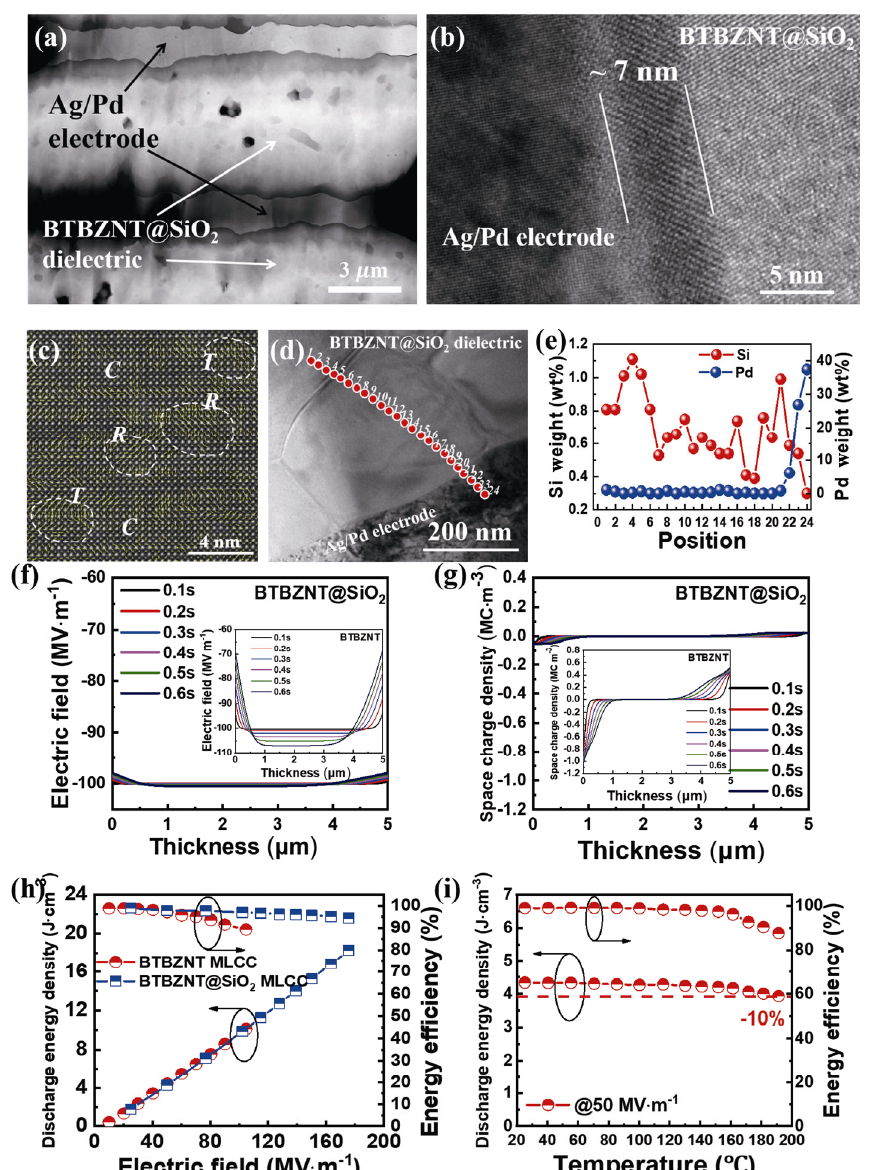
Fig. 29 (a) Low-magnification TEM dark-field image of BTBZNT@SiO 2 MLCCs. (b) High-resolution TEM bright-field image of the interface between the electrode and dielectric for BTBZNT@SiO 2 MLCCs. (c) Domain structure for BTBZNT@SiO 2 ceramics. (d, e) EDS analysis results of the Si and Pd distribution along the points from 1 to 24 in (d). The change in electric field concentration (f) and space charge density simulations (g) of the BTBZNT@SiO 2 and BTBZNT MLCC from 0.1 to 0.6 s after applying an electric field of 100 MV·m –1 . (h) Energy-storage performance of the BTBZNT